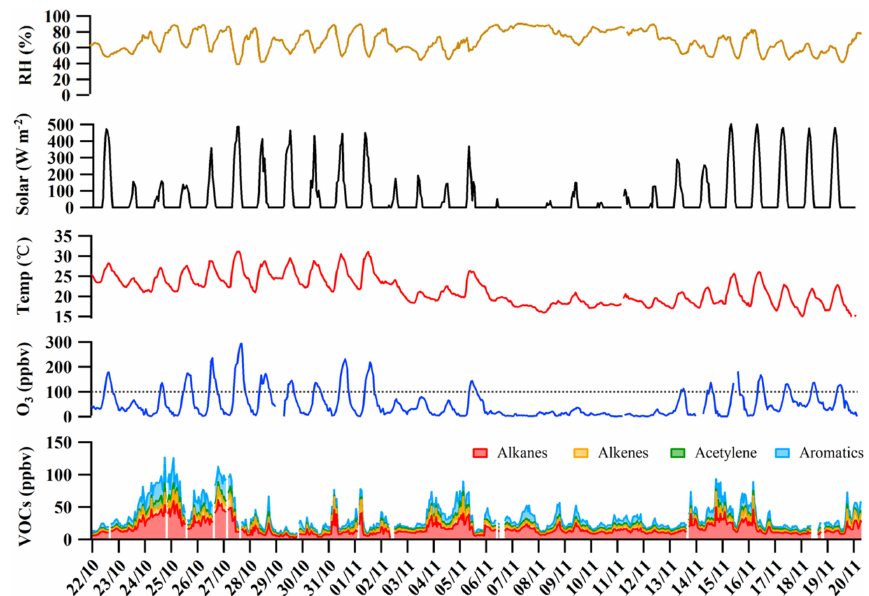
Figure 2. Time series of O 3 , volatile organic compounds (VOCs) and meteorological parameters observed at the Heshan